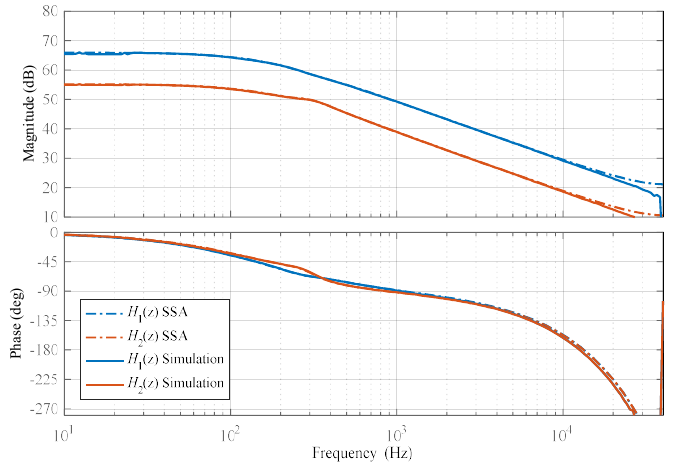
Figure 18. Bode diagram of H 1 (s) and H 2 (s) .